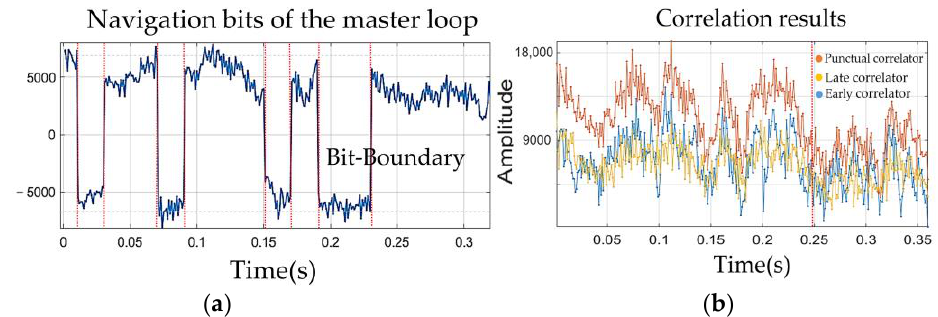
Figure 13. ( a ) Using tracked bit-edge as a code phase indicator for the slave loop C / N 0 = 28; ( b ) output of the correlator in the master loop with signal interference (0.25 s).